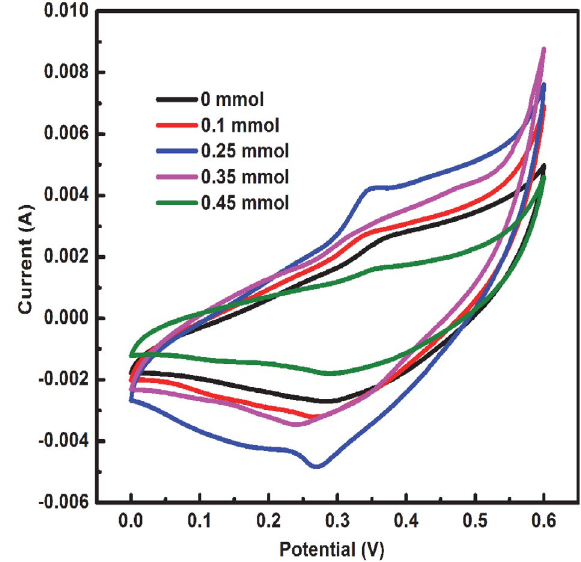
Fig. 5. CV curves of the as-prepared electrodes at 5 mV s –1 .